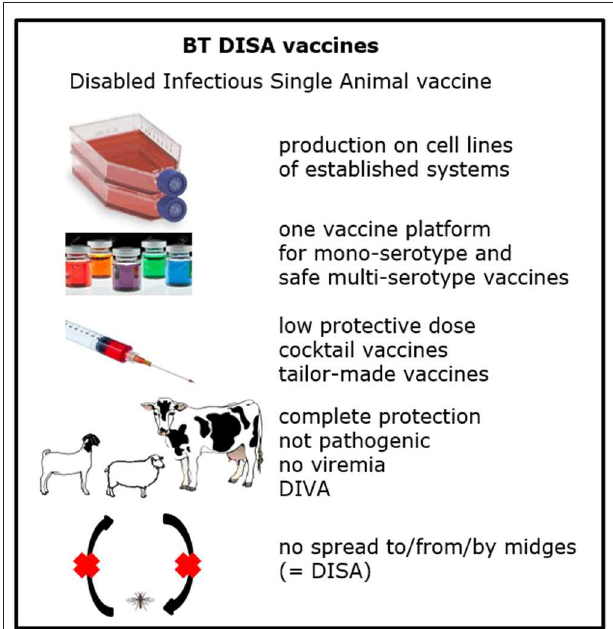
FIGURE 4 | Overview of the vaccine profile of the DISA vaccine